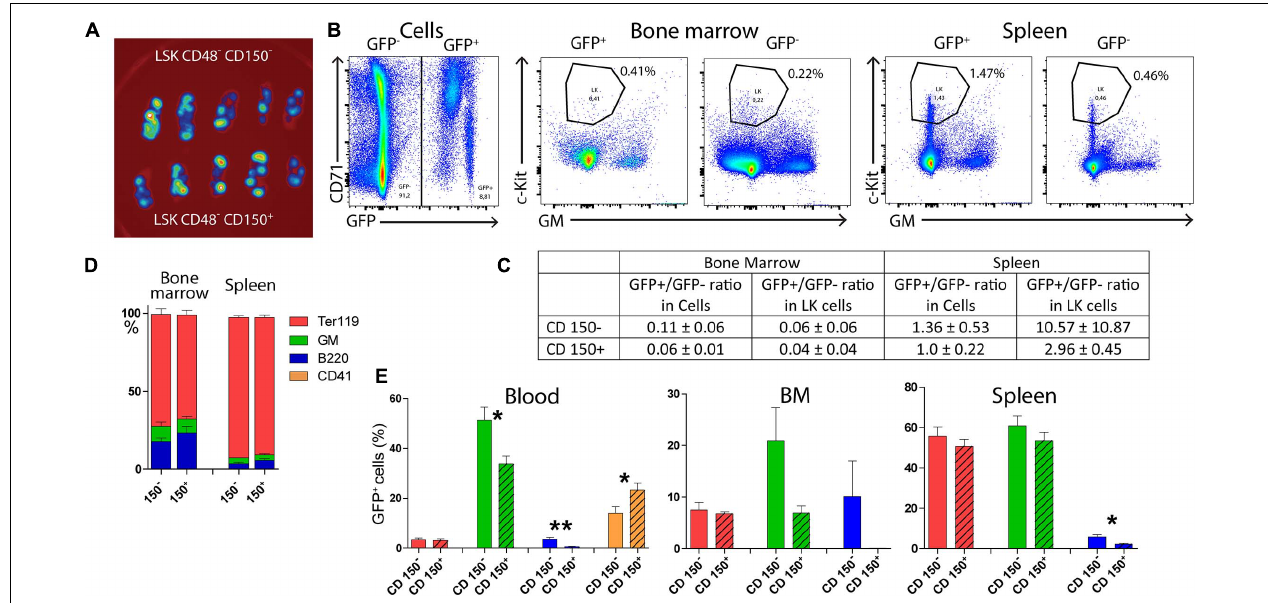
FIGURE 5 | Both CD150 + and CD150 − LSK CD48 − cells reconstitute damaged hematopoiesis. Ten female C57Bl/6 mice were irradiated at 6.5 Gy and transplanted with 400 LSK CD48 − , either CD150 − or CD150 + cells sorted from the bone marrow two UBC-GFP mice. Two weeks after transplantation, the peripheral blood and hematopoietic tissues were collected and analyzed. (A) Spleens visualized for green fluorescent protein (GFP) fluorescence. (B) Examples of the gating of LK cells in the chimeric bone marrow and spleen cells. (C) Ratio between GFP + and GFP − cells in all cells and LK cells. (D) The proportion of all (GFP + and GFP − cells, not distinguished) Ter119 + (erythroblasts), GM + (myelocytes and monocytes), and B220 + (B cells) cells in the bone marrow and spleen of transplanted mice. (E) The occurrence of GFP + red blood cells (Ter119), granulocytes–macrophages (GMPs), B lymphocytes (B220), and platelets (CD41) in the peripheral blood. * p < 0.05, ** p < 0.01. See Supplementary Figures 6, 8 for the gating used for sorting cells for transplantation and analysis of red blood cells and platelets in the